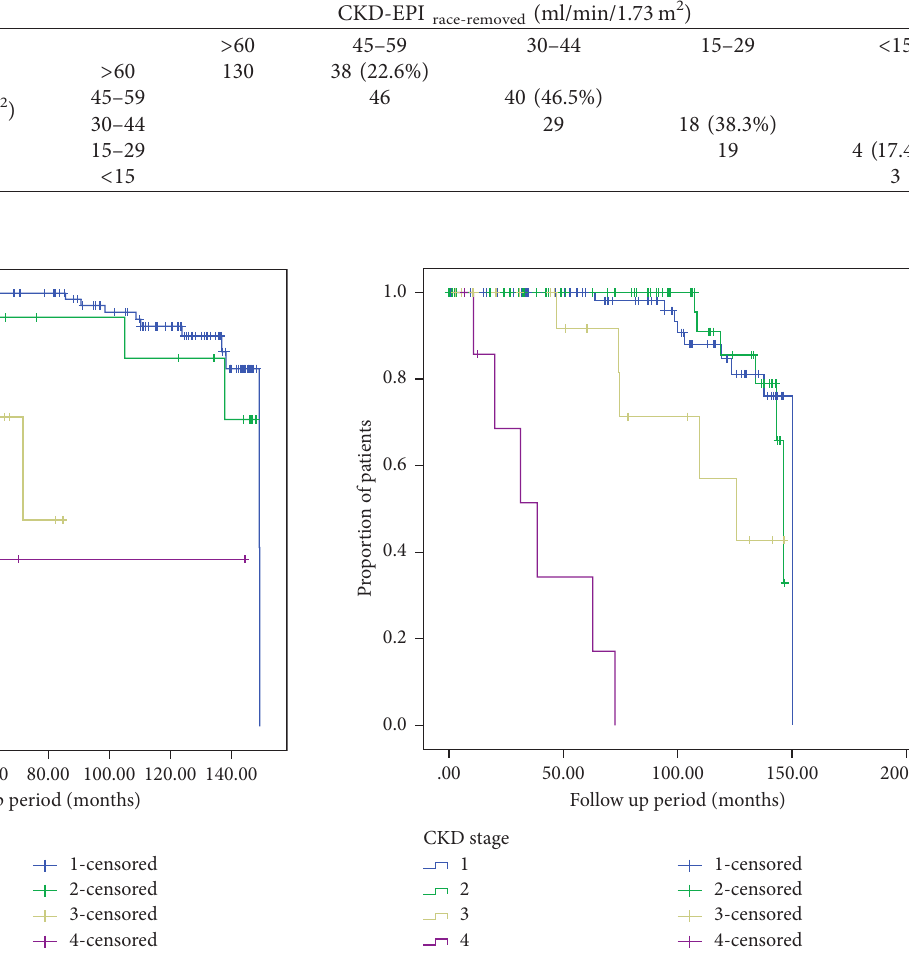
Figure 1: Kaplan–Meier curves depicting median time to CKD G5 amongst AA patients who were not reclassified by MDRD race re- � 164). moved ( N